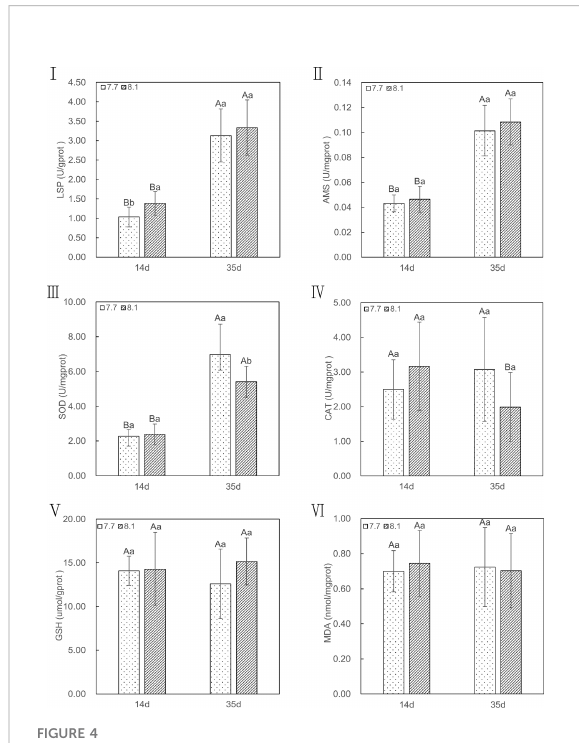
FIGURE 4 LSP, AMS, SOD, CAT, MDA, and GSH content of razor clam cultured under pH 7.7 and pH 8.1 exposure at the 14-day and 35-day experiment. LPS (I): lipase, AMS (II): amylase, SOD (III): Superoxide dismutase, CAT (IV): catalase, GSH (V): glutathione, MDA (VI): malondialdehyde. Note: different capital letters indicate signi fi cant differences (P<0.05) between the same groups at different time points; different lowercase letters indicate signi fi cant differences (P<0.05) between groups at the same point in